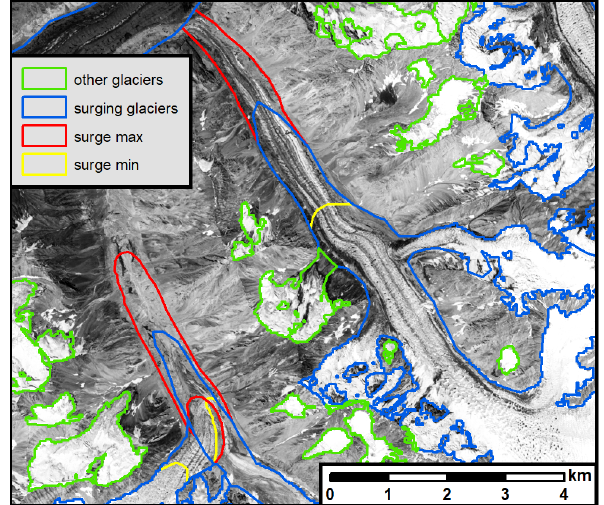
Figure 4. Comparison of glacier outlines from the original in- ventory GI-2 (blue/green) and the additional GI-3min/GI-3max (yellow/red) showing the minimum and maximum extents of two surging glaciers. Image acquisition date and source: 1968, https: //earthexplorer.usgs.gov (last access: 17 October